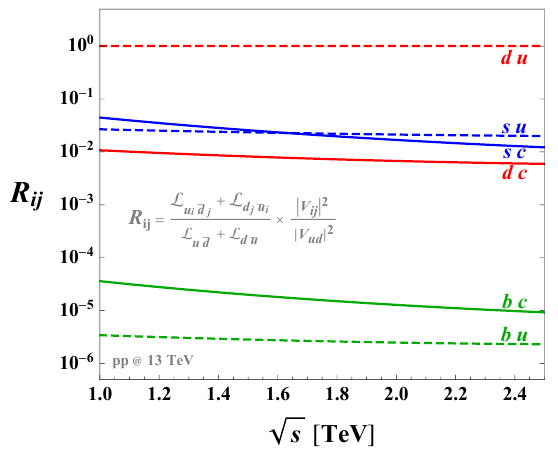
Figure 1 . Suppression factors for the charged-current Drell-Yan cross section with different collid- ing quark flavors, R ij , stemming from the PDF and the CKM matrix, see eq. (4.5). √ scale µ = s . The suppression from R is compensated by the energy enhancement ij F √ ( s/m ) 4 ∼ O (10 5 ) . Thus, a measurement of the cross section in the tails with O (10%) W precision would probe cs and cd at the level of (cid:15) ∼ O (10 − 2 ) . The weak dependence on X the energy across the most sensitive bins allows to rescale the limits for different flavor combinations provided the lepton cuts are sufficiently inclusive (see section